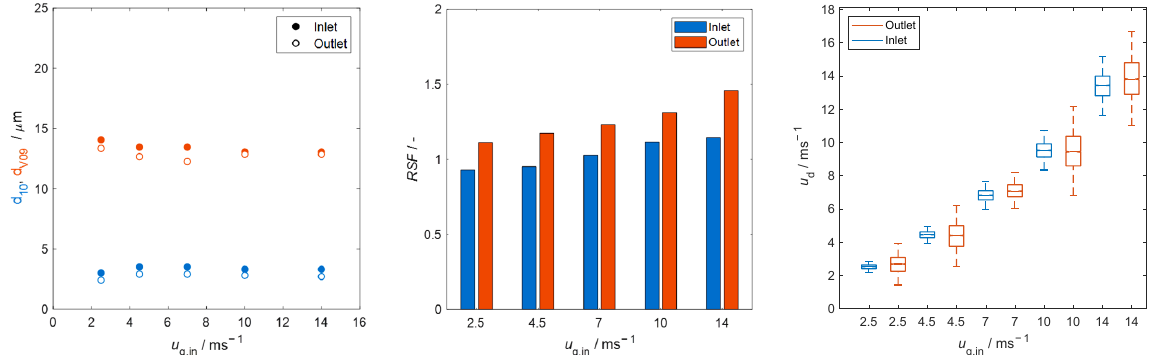
Figure 7. Diameter ( left ), relative span factor ( center ) and velocity ( right ) of the droplets at inlet and outlet of the unloaded microwave applicator.